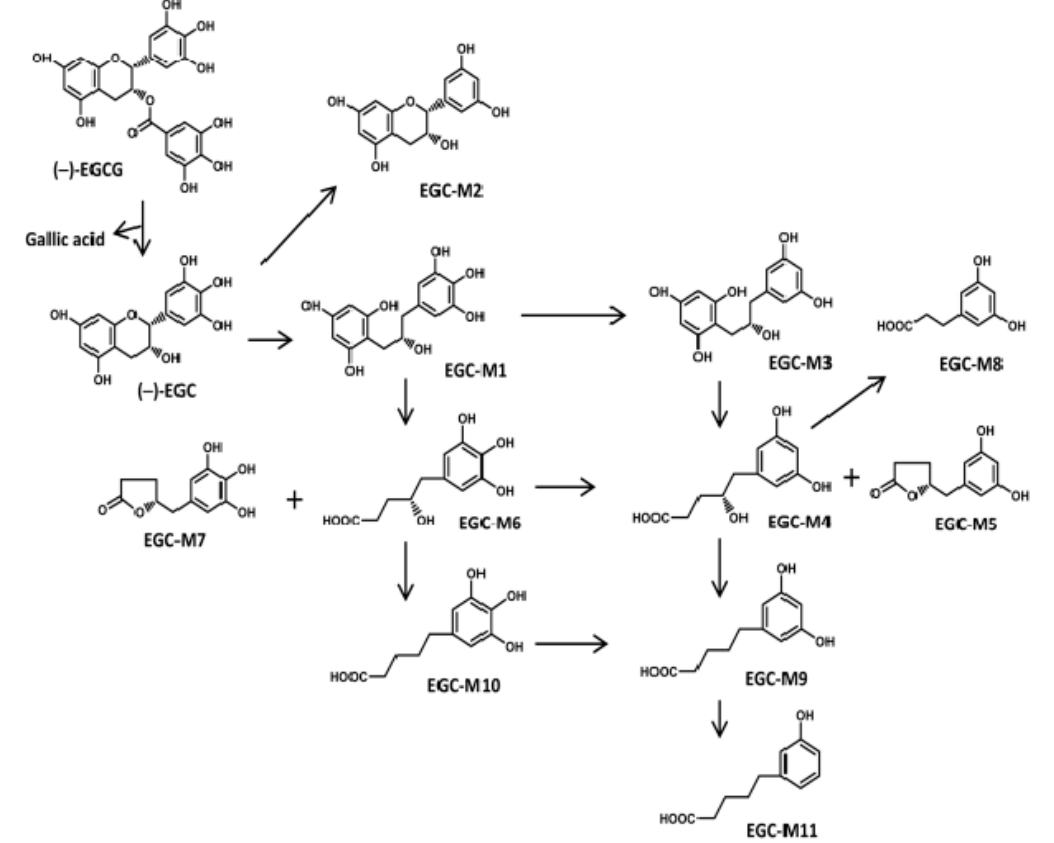
Figure 1. Chemical structures of EGCG metabolites based on data from Takagaki et al. [41].